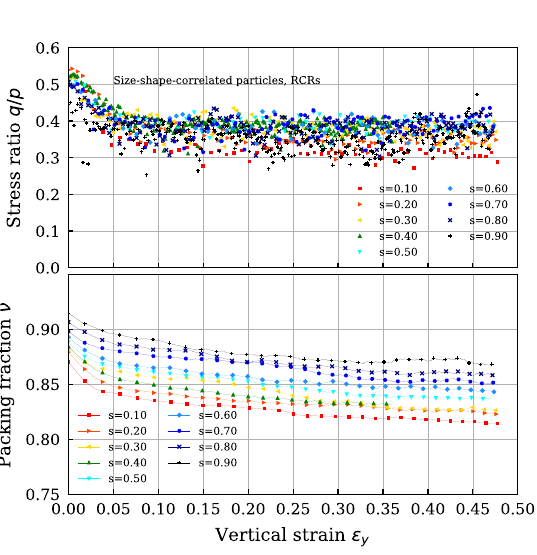
Figure 2. Closeup views of some of the samples at the end of isotropic compression. (a) Discs series. (b) RCRs series. Grey particles represent floating particles (i.e. with zero or one con- tact).